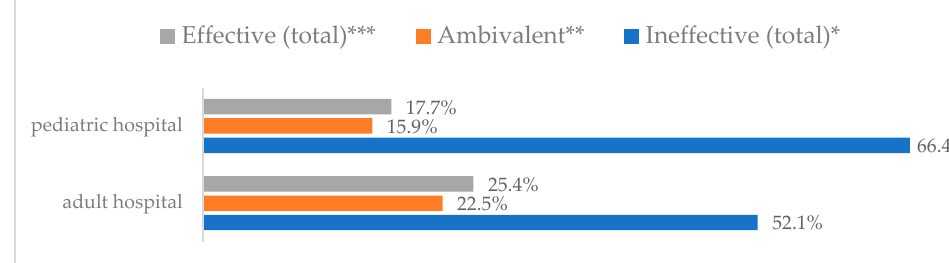
Figure 34. Taking vitamin C daily to prevent influenza virus infection by profession ( N = 905). *Sum of responses: completely ineffective, ineffective, rather ineffective; **Response: neither ineffective nor effective; ***Sum of responses: rather effective, effective, completely effective. Figure 35. Taking vitamin C daily to prevent influenza virus infection by seniority ( N = 905). *Sum of responses: completely ineffective, ineffective, rather ineffective; **Response: neither ineffective nor effective; ***Sum of responses: rather effective, effective, completely effective.